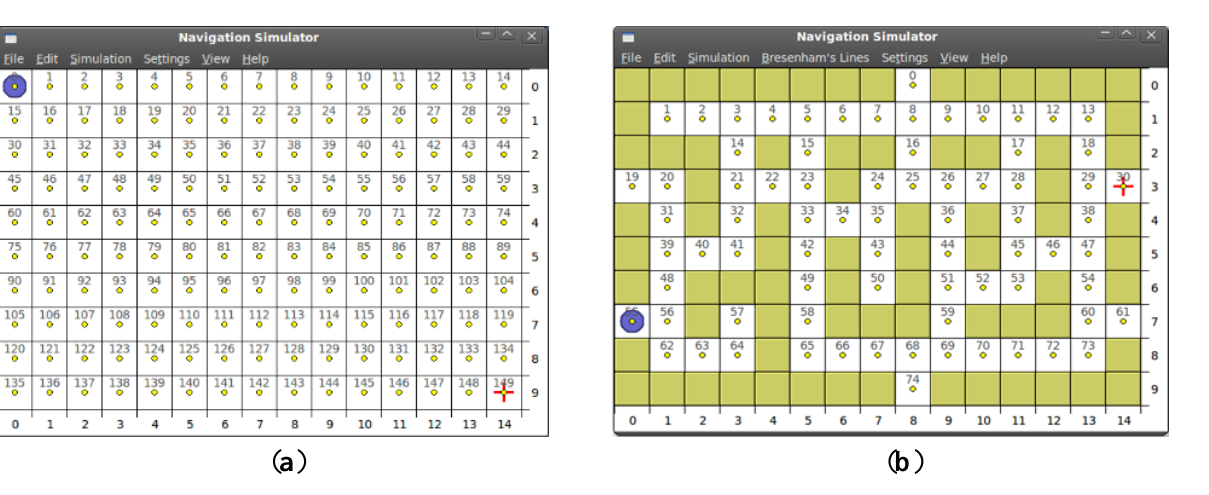
Figure 7. Two examples from the map test-suite, designed by HCTLab team: ( a ) A